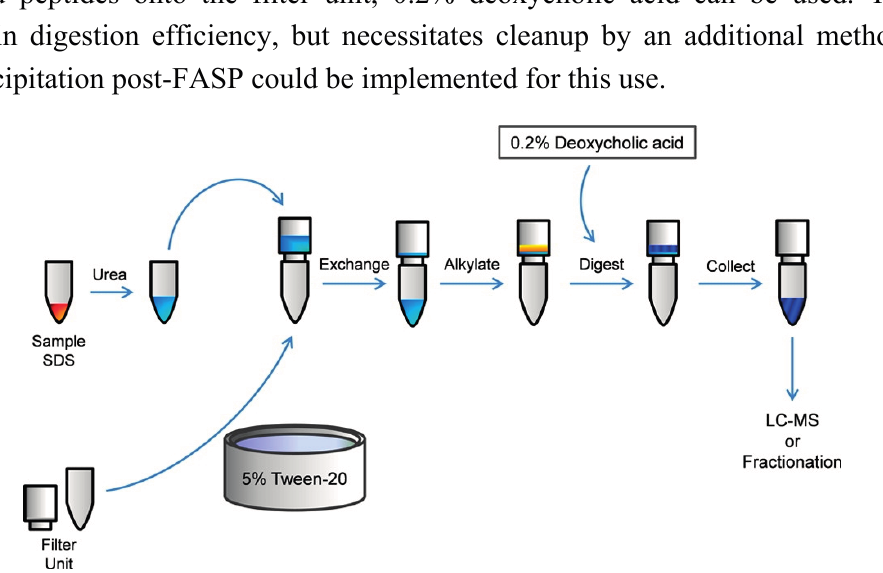
Figure 3. Enhanced filter-aided sample preparation (FASP) workflow. Samples